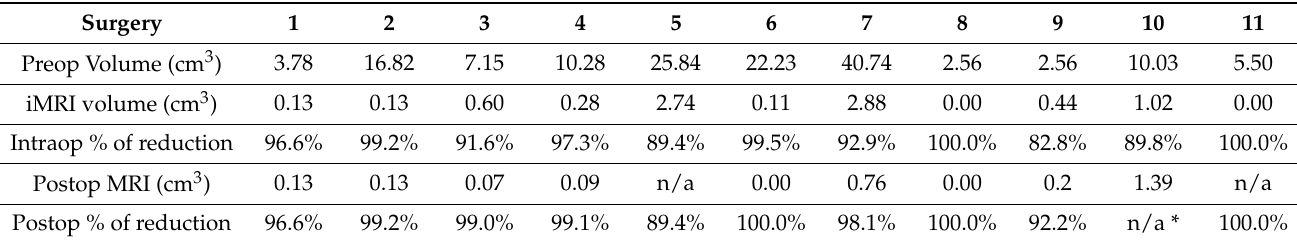
Table 5. Volumetric